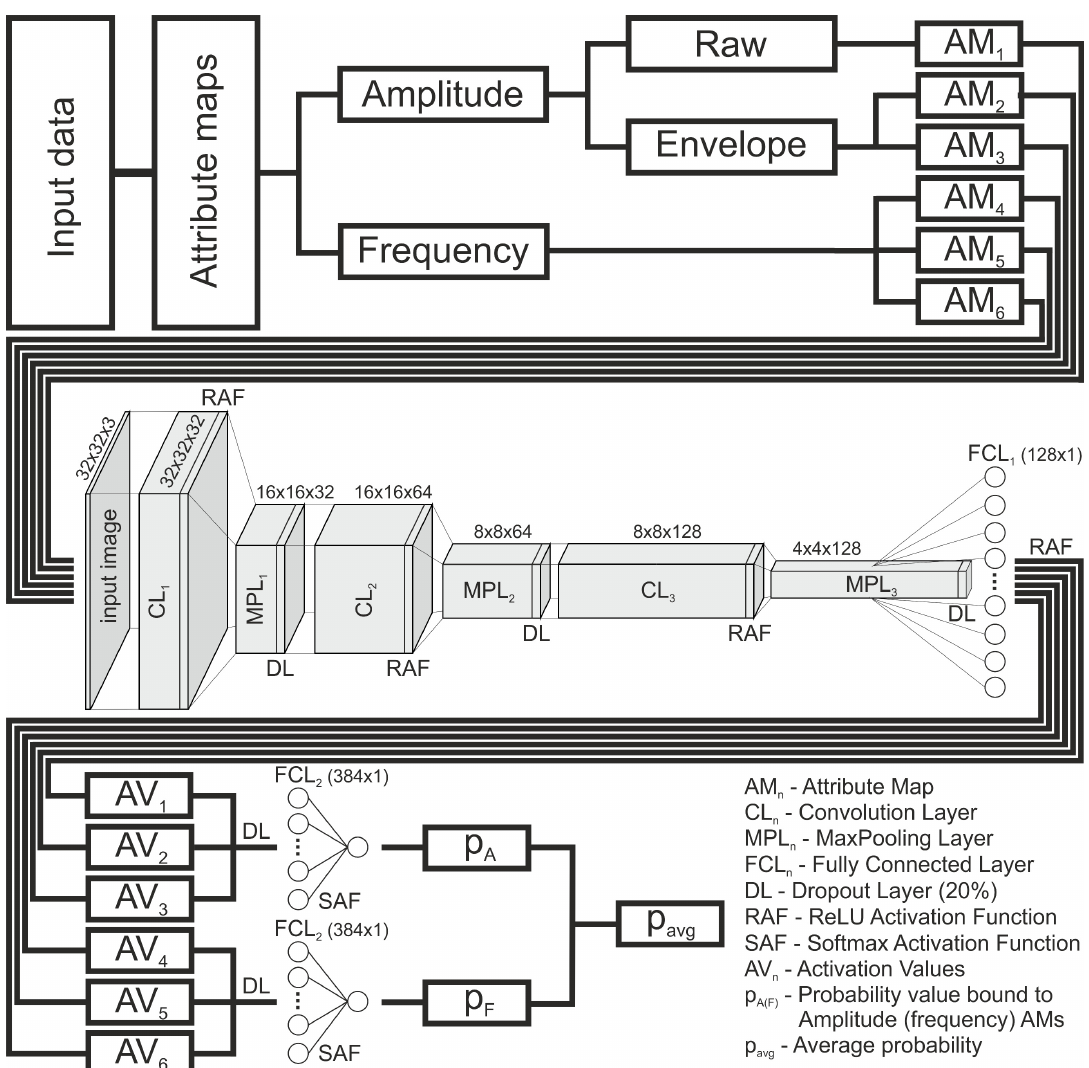
Figure 4. Flow diagram illustrating a deep learning-based solution model and the employed Visual Geometry Group (VGG)-16 convolutional neural network (CNN)